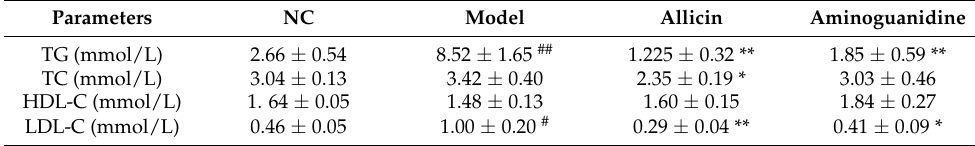
Table 1. Effect of allicin on blood metabolic indexes in diabetic rats.